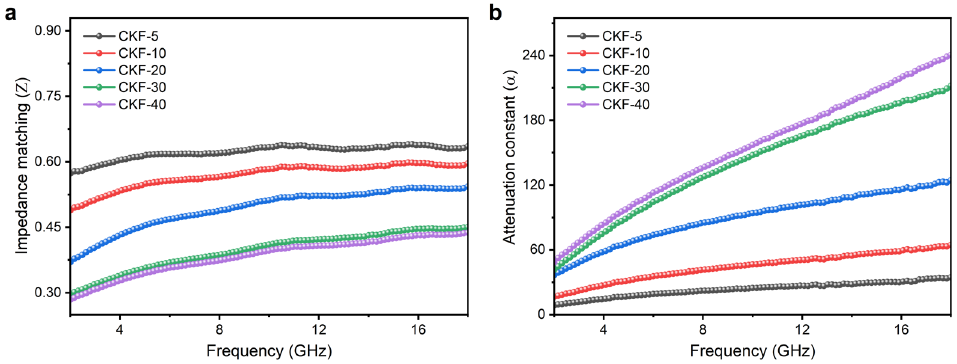
Figure 8. Calculated ( a ) impedance matching and ( b ) attenuation constant of CKF-filled paraffin composites with different filler loading.